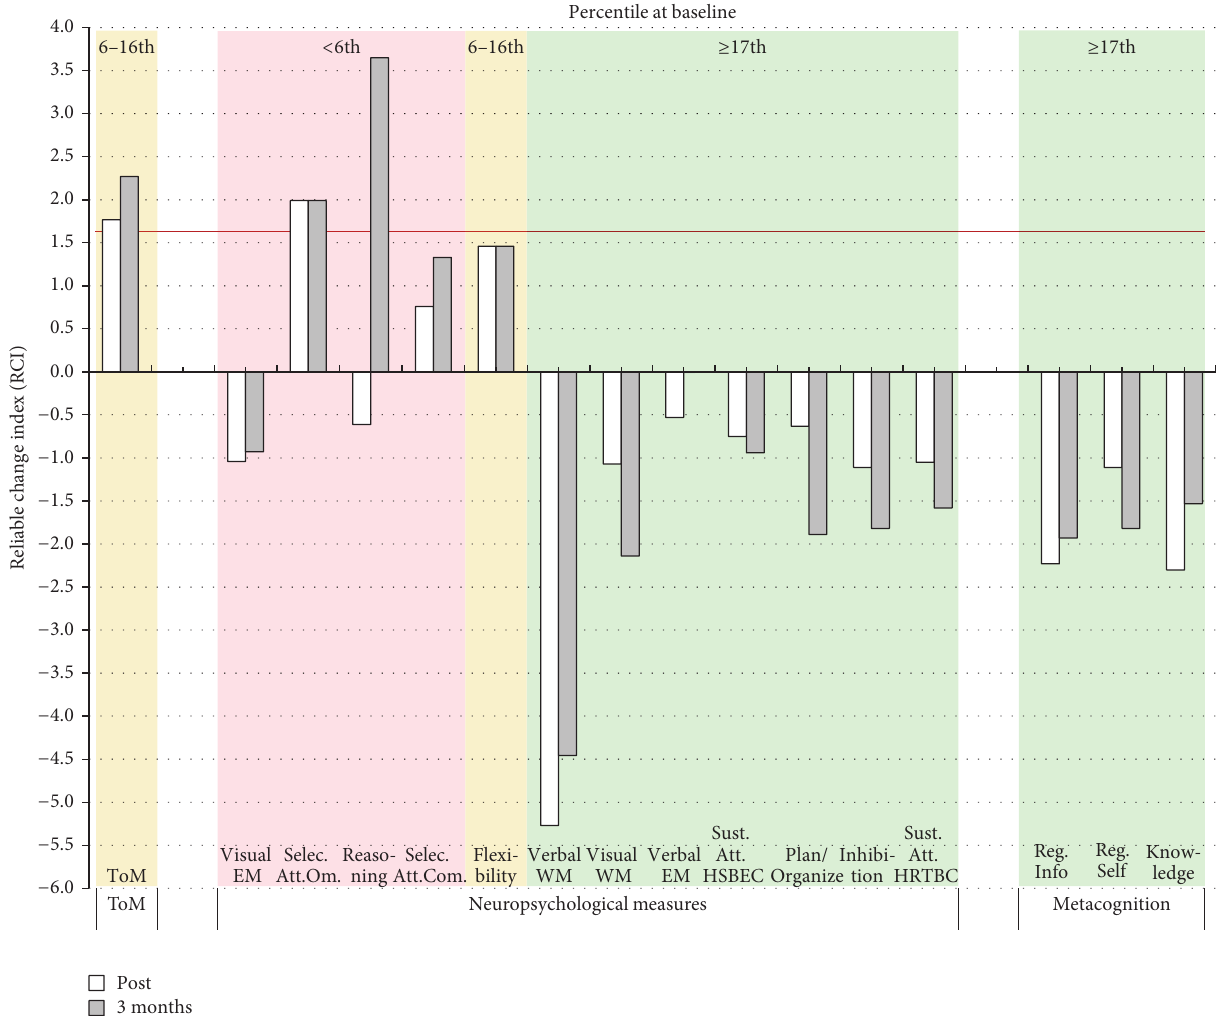
Figure4:ChangesinToMandneuropsychologicalandmetacognitiveresultsforCaseCforeachofthefollow-upassessments(posttreatment, 3 months and 1 year after treatment). The color of the background indicates the severity of the deficit at baseline. A red background indicates a severe impairment at baseline ( ≤ 6th percentile), a yellow background indicates an important impairment (7th to 16th percentile), and a green background indicates a normal performance ( ≥ 17th percentile). The horizontal red line indicates the statistical RCI threshold of 1.64. ToM = theory of mind; EM = episodic memory; selec. att. = selective attention; om. = omission; com. = commission; WM = working memory; sust. att. = sustained attention; HSBEC = Hit Standard Error Block Change; HRTBC = Hit Reaction Time Block Change; reg. info = Metacognitive Regulation Informant Report; reg. self = Metacognitive Regulation Self Report; knowledge = metacognitive knowledge.